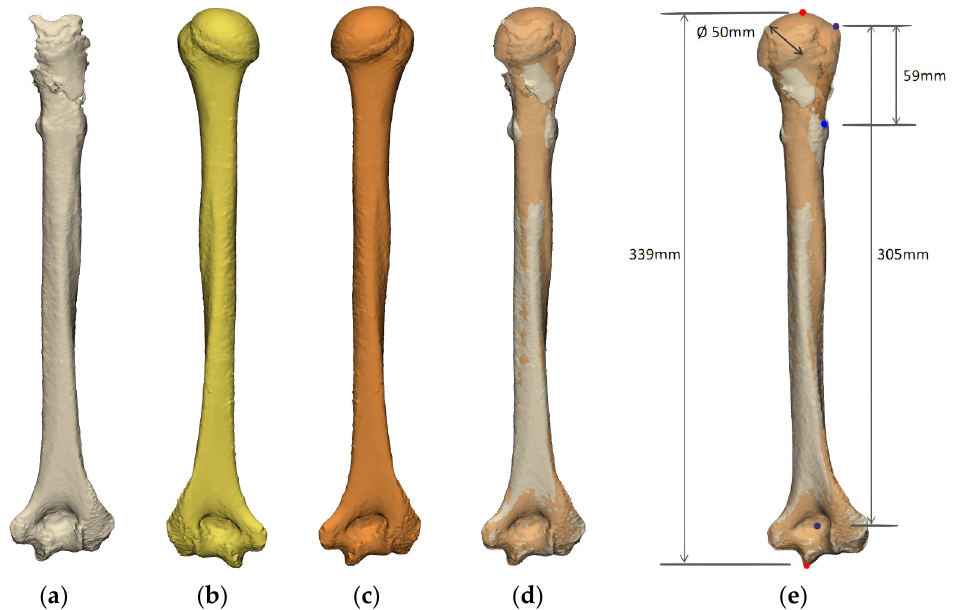
Figure 5. Evaluation of the humerus native anatomy ( a ) combined with the use of the contralateral side ( b ), which is mirrored ( c ) and overlaid onto the native anatomy ( d ) to ascertain the humeral length and subsequent amount of humeral bone loss ( e ) (images from Reflect COMPLEX TM (Akunah, Brisbane, Australia)).